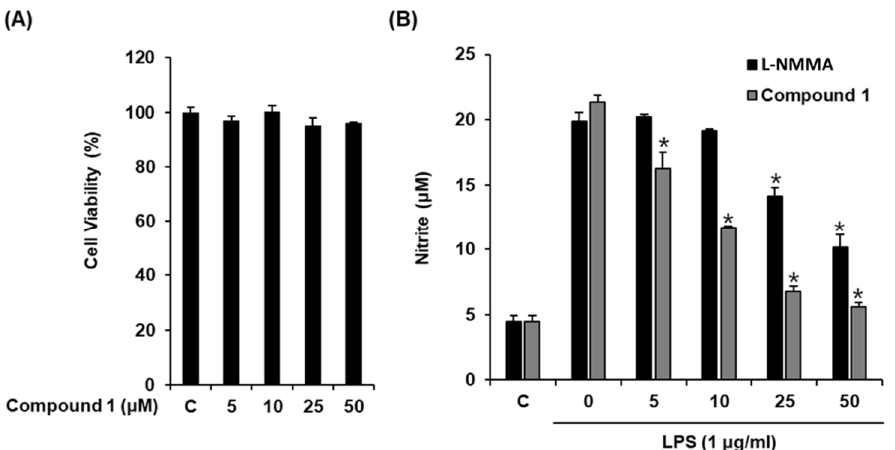
Figure 3. Effect of compound 1 on the lipopolysaccharide (LPS)-induced NO production in RAW 264.7 mouse macrophages. ( A ) The viability of RAW 264.7 cells incubated with compound 1 for 24 h was measured using an MTT assay. ( B ) The effect of compound 1 and L -NMMA as a positive control in LPS-treated RAW 264.7 macrophages was detected using the Griess reagent (mean ± SD, * p < 0.05 as compared to the LPS-treated group).